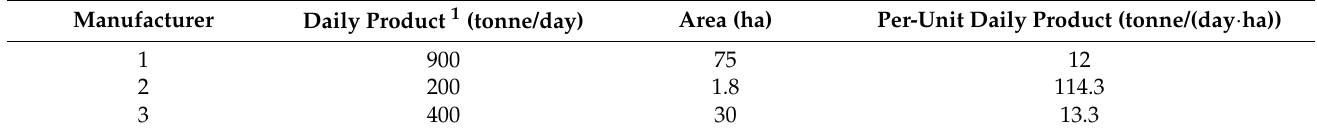
Table 10. Iranian flat glass manufacturer data.